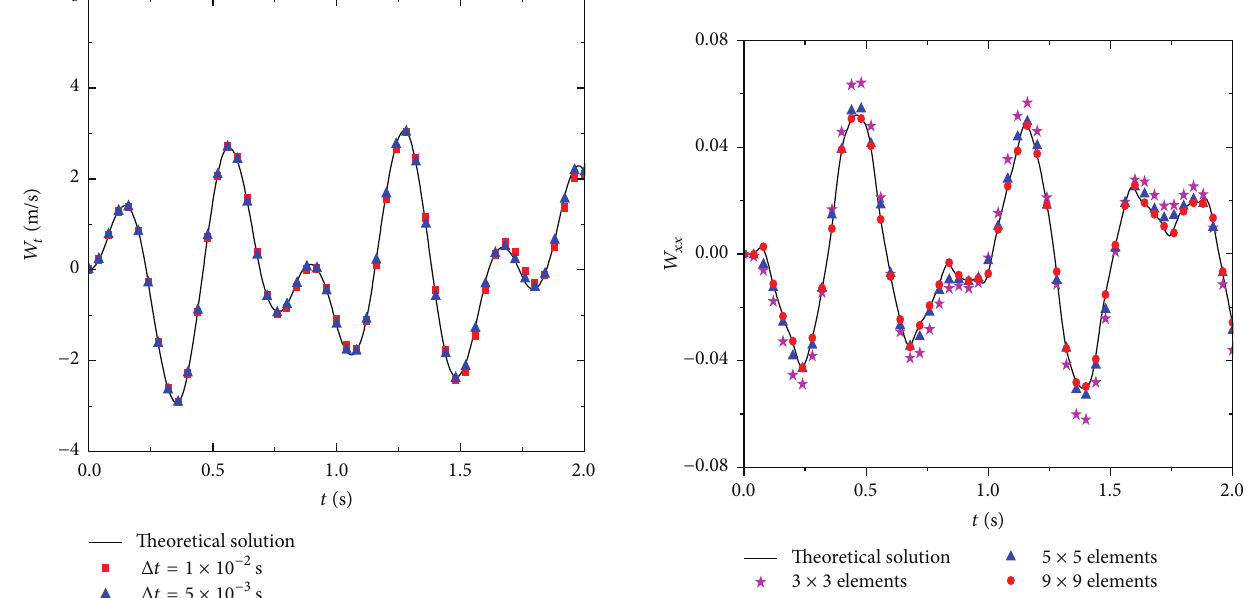
Figure 8: Numerical result of acceleration 𝑊 𝑡𝑡 with 5 × 5 manifold elements.